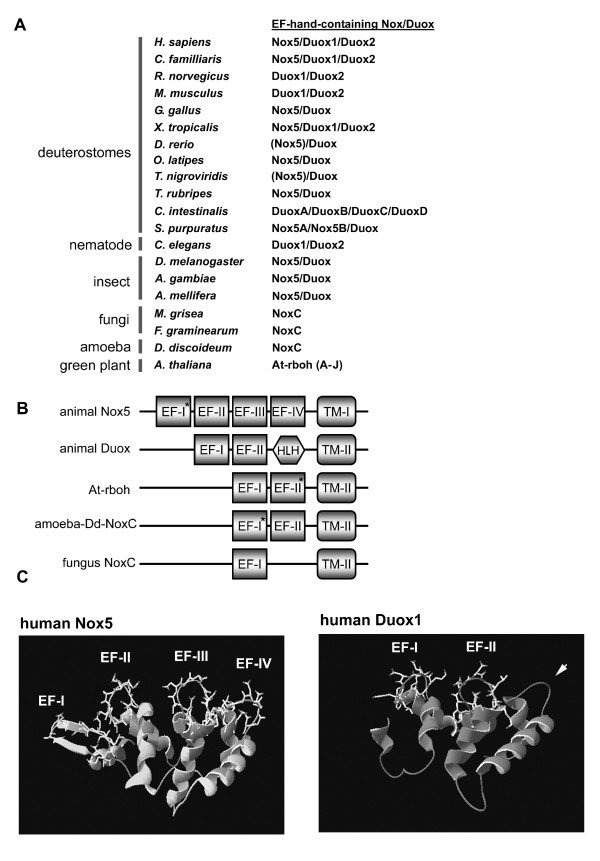
Sequences of EF-hand motifs in Nox5, Duox, plant Nox, and NoxC. (A) EF-hand containing Nox/Duox family members are listed and demonstrate the widespread occurrence of these Noxes. Parentheses represent the presence of Nox5 ortholog in the T. nigroviridis and D. rerio genomes, which clearly belongs in the Nox5 subgroup (#45 and #47 in Figure 2), but appears to lack the N-terminal EF-hand-containing domain as discussed in the text. (B) Based on alignments shown in Additional files 2 and 8, the arrangement of EF-hand motifs within the calcium-binding domain of calcium-regulated Noxes are shown schematically. EF-I to EF-VI in squares indicate each canonical EF-hand motif. TM-I and TM-II indicate the 1st or 2nd TM segments. Asterisks represent atypical EF-hand motifs that differ from consensus sequences at positions 1, 3, or 12, normally the most conserved positions [63]. HLH, refers to a non-canonical helix-loop-helix predicted structure. (C) A structural homology model of the EF-hand-containing domains of human Nox5 (upper panel) and human Duox1 (lower panel) using a comparative protein modeling method (SWISS-MODEL) and visualized with Deep View Swiss-PDB. The N-terminal region of Nox5 and human Duox1 was calculated using the structure of calcineurin B subunit isoform 1 as a fit template. The fit of the N-terminal region of Duox1 corresponding to the first EF-hand-like motif of Nox5 was not accurate enough to determine the molecular model. The arrow indicates the position of Duox1 corresponding to the 4th EF-hand motif of Nox5 and models as a HLH structure that lacks canonical calcium binding amino acid residues. Side chains of canonical EF-hand motifs are indicated. Conserved sequences among EF-hand regions in Noxes and Duoxes are aligned and compared in Additional file 2.